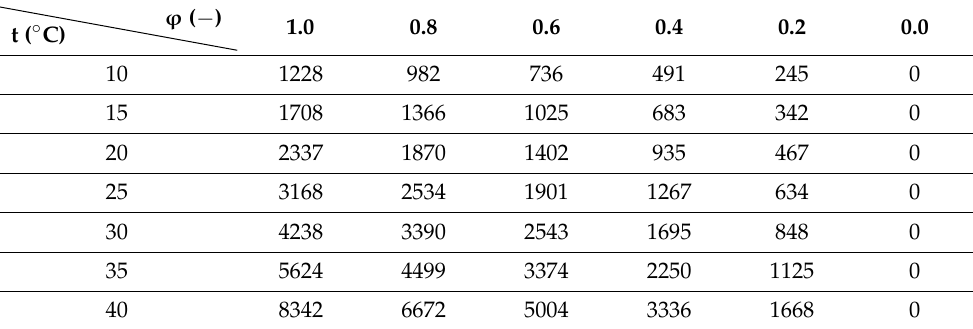
Table 2. Partial vapour pressures pp (Pa) for various temperature values t ( ◦